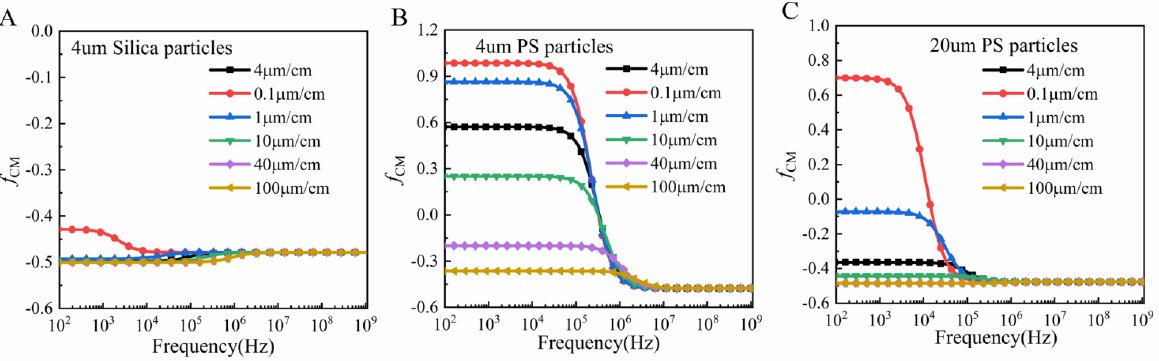
Figure 4. ( A ) CM factor of the 4 µm polystyrene spheres. ( B ) CM factor of the 4 µm silica particles. ( C ) CM factor of the 20 µm polystyrene spheres.